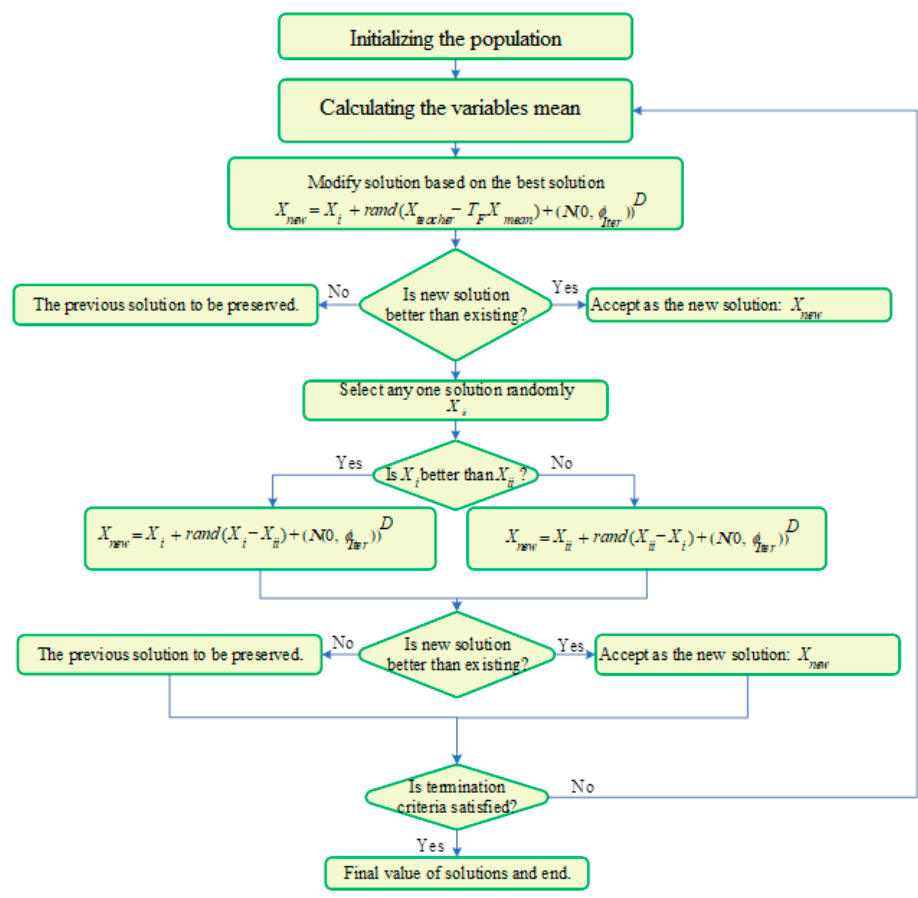
Figure 1. Flowchart of the proposed AGTLBO algorithm.